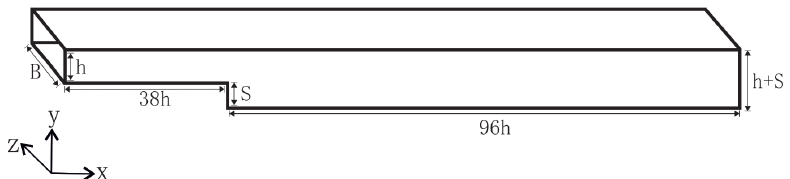
Figure 1. The backward facing step geometry studied here, with an expansion ratio of 1.98.